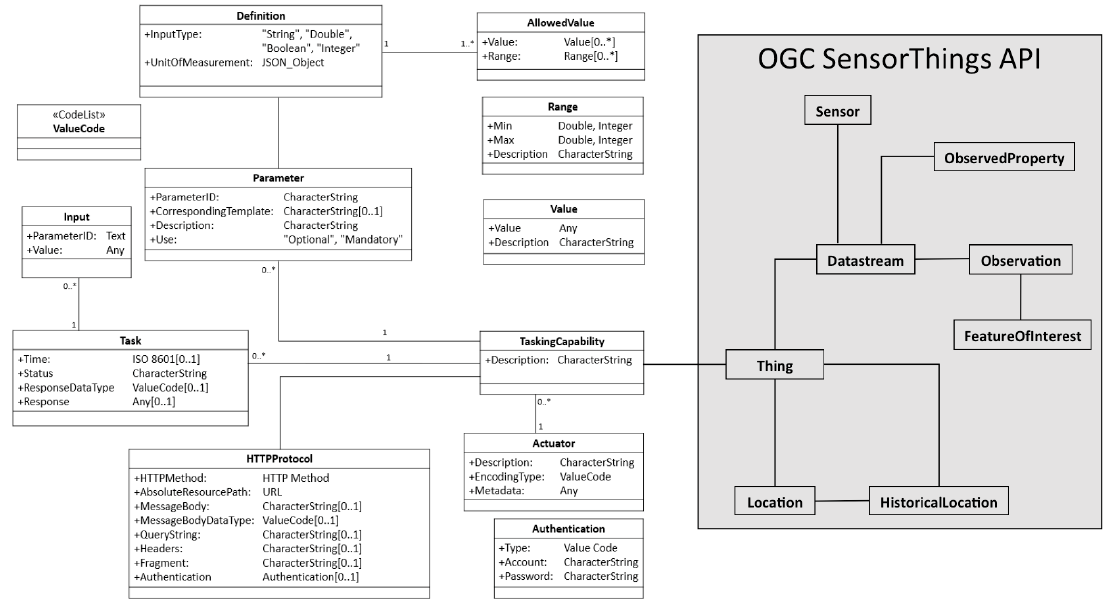
Figure 5. The data model of tasking capability.